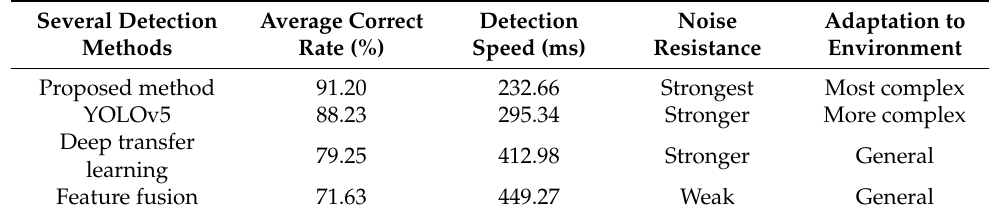
Table 2. Comprehensive comparison of proposed and existing security detection